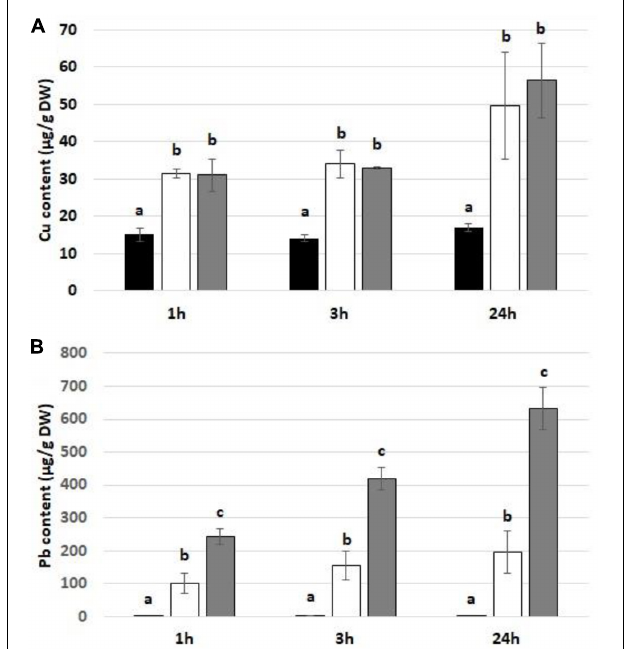
FIGURE 1 | The level of Cu (A) and Pb (B) in soybean seedlings exposed to the respective metal for 1, 3, and 24 h in control seedlings (black bars) and seedlings exposed to Cu at the concentration 15 mg/l or Pb at the concentration 300 mg/l (white bars) and Cu at the concentration 30 mg/l or Pb at the concentration 600 mg/l (gray bars). The statistically significant differences in relation to the control are marked with different letters (a–c). The results are means of three experimental repetitions ± standard error.